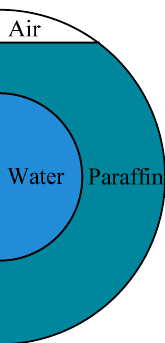
Figure 1. Schematic of one half of the latent heat storage (LHS) unit. Table 1. Thermophysical